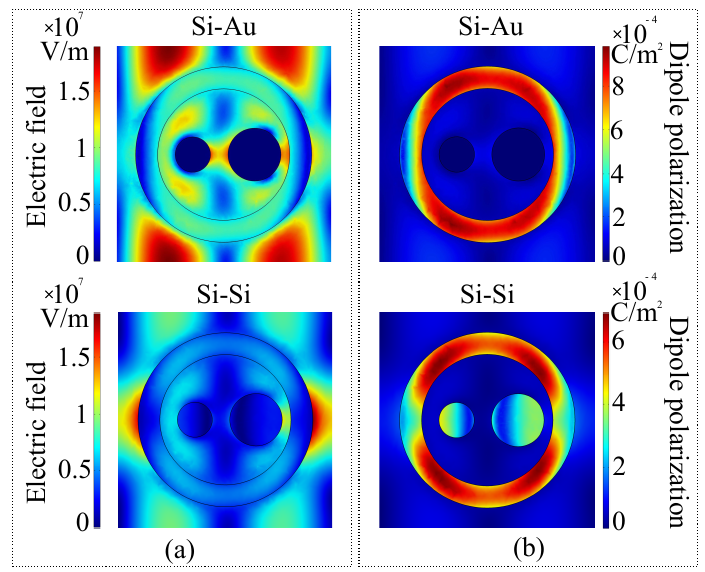
Figure 6. ( a ) Electric field norm and ( b ) induced dipole polarization in the metasurface plane taken at the dominant resonance frequency of the gold − silicon and all − silicon